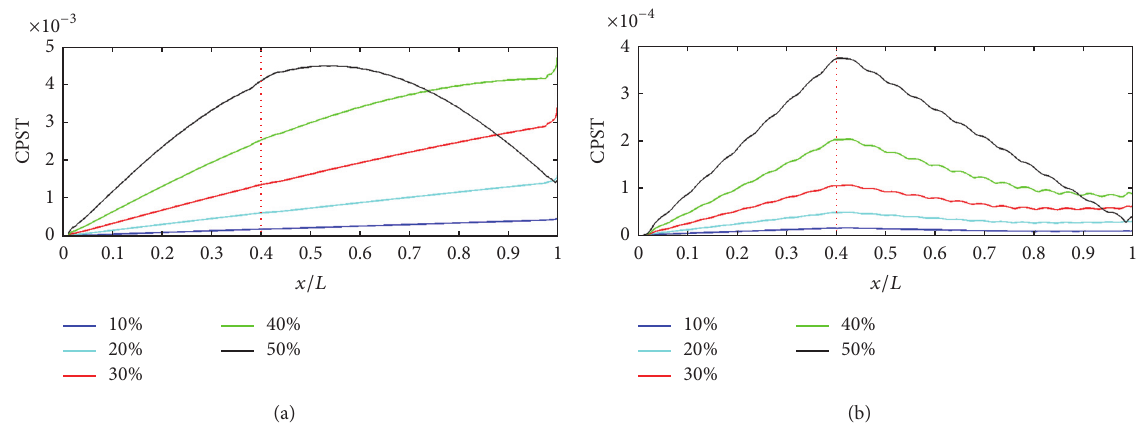
Figure 17: CPST of different damage levels with the mass which is 200 Kg: (a) is for the acceleration responses and (b) is for the displacement responses.